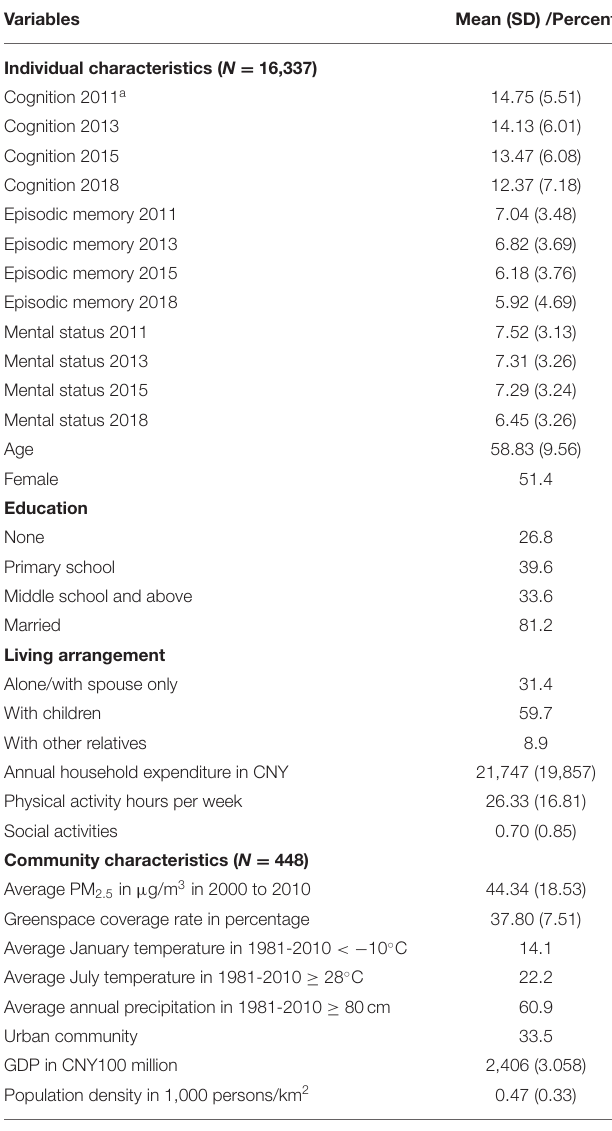
TABLE 1 | Descriptive statistics for individual and community